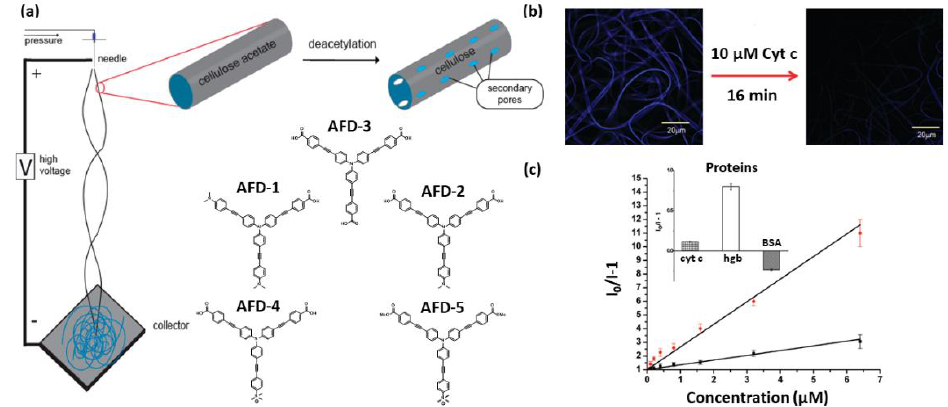
Figure 6. ( a ) Schematic representation of the preparation of electrospun nanofibers from cellulose acetate encapsulating anionic fluorescent dendrimer (AFD). ( b ) The fluorescence of the AFD-functionalized nanofibers is quenched by introduction of metalloproteins, such as cytochrome c, cyt c. ( c ) Stern-Volmer plots for cyt c (black) and Hgb (red) [137]. Copyright: images adapted and reproduced with permission from © 2010, American Chemical Society.